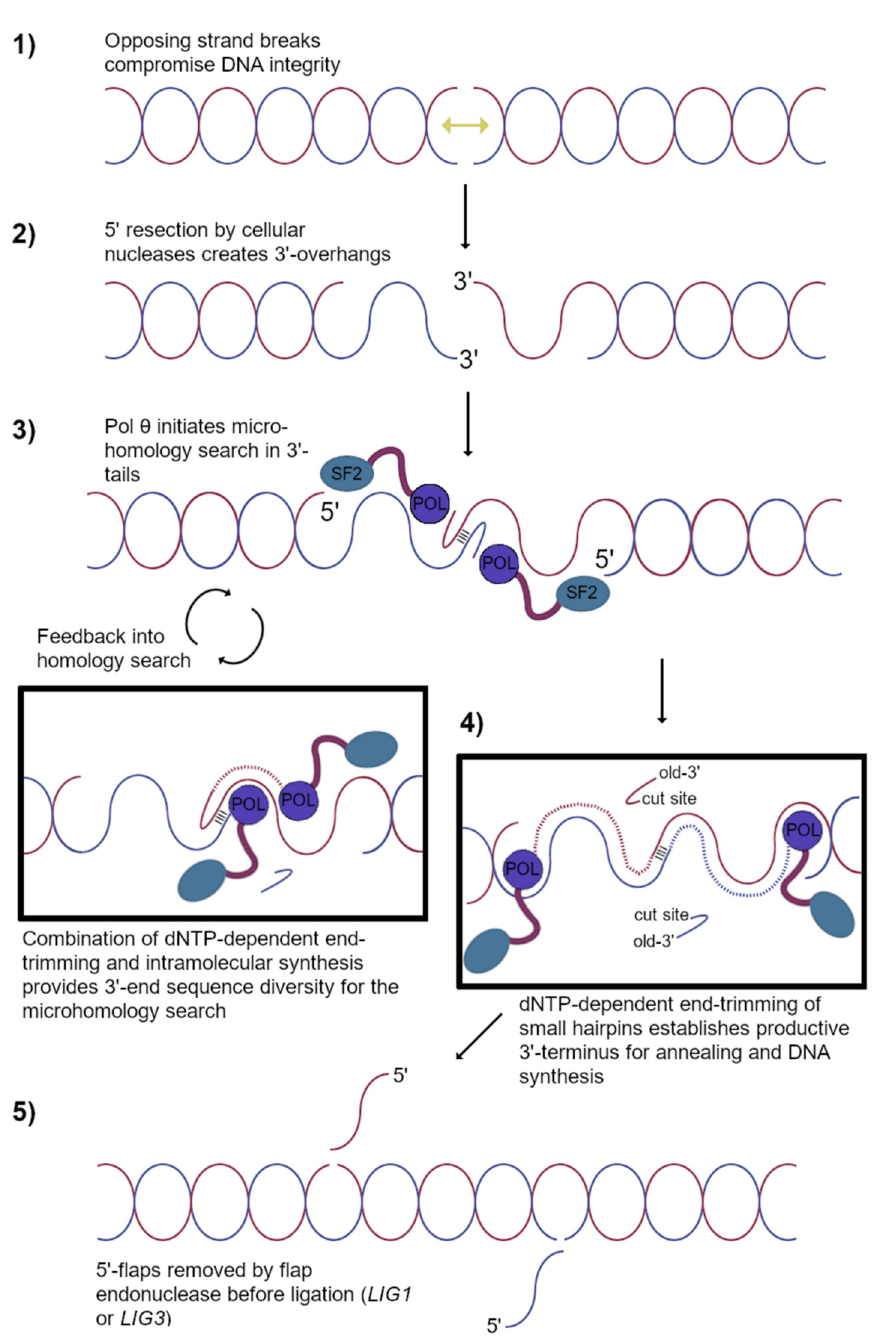
Figure 4. The repair of DSBs by the TMEJ pathway depends critically on pol θ to provide dNTP-dependent 3 ′ -end trimming and template-dependent DNA synthesis activities at appropriate microhomologies.